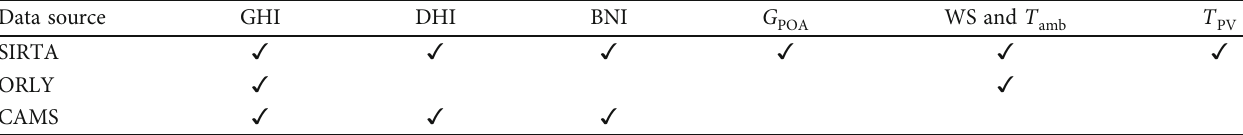
Table 1: Available data versus data